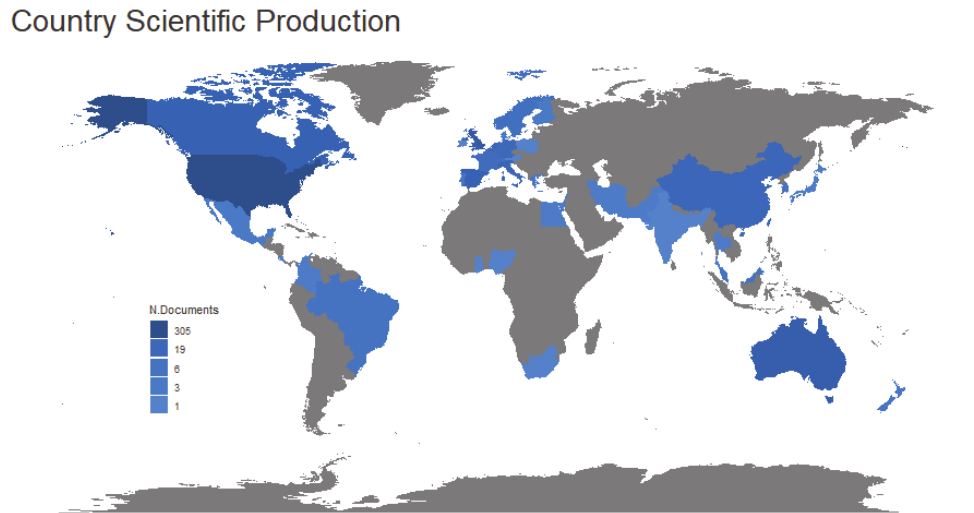
Fig. 6 The frequency of the keywords used in different corporate governance studies